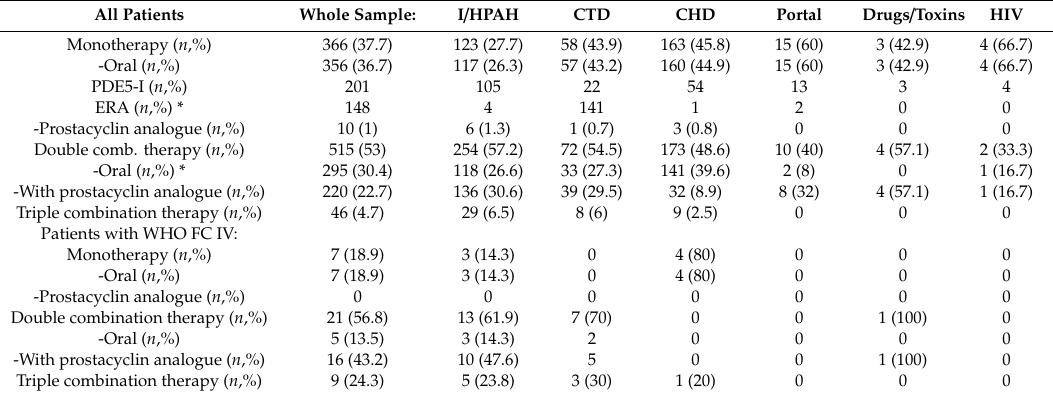
Table 4. PAH-Specific Medications Among Adult PAH Patients in the Data Base of Pulmonary Hypertension in the Polish Population (BNP-PL) Registry at Enrollment.